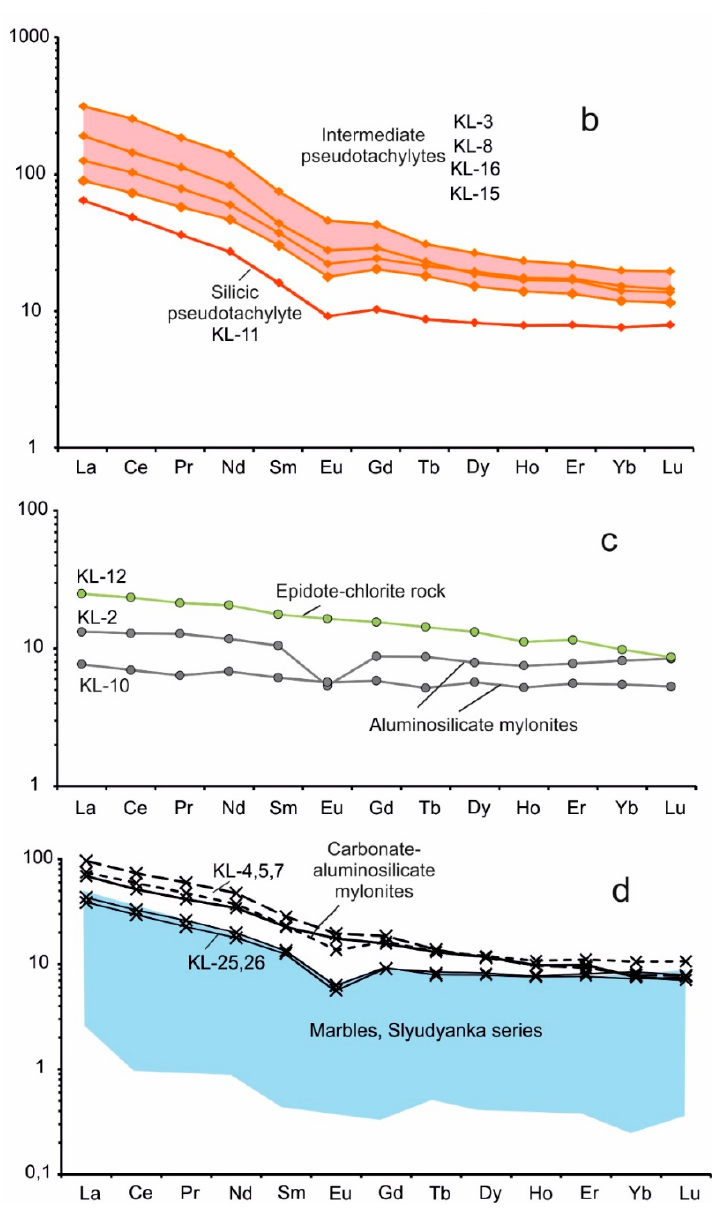
Figure 7. Chondrite-normalized REE spectra of rocks from the MSF: ( a ) basic pseudotachylytes; ( b ) intermediate and silicic pseudotachylytes; ( c ) aluminosilicate mylonites and epidote-chlorite rock; ( d ) carbonate-aluminosilicate mylonites. Shown for comparison in panel c is the range of carbonate rocks of the Slyudyanka complex (without fine-crystalline marbles with lower REE abundances) [76]. For normalization, the chondrite composition was used after [77].